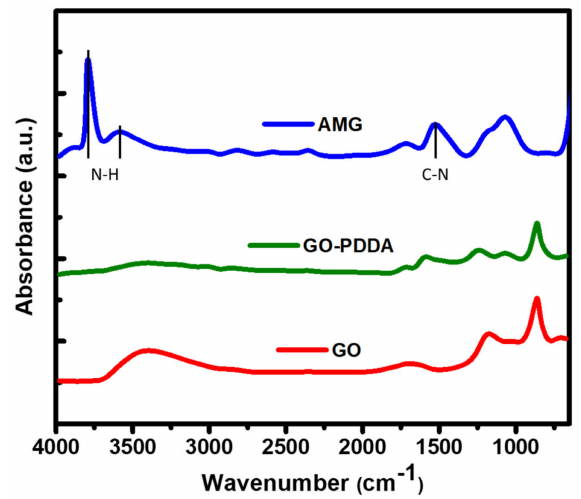
Figure 5. FTIR analysis of GO, GO-PDDA, and